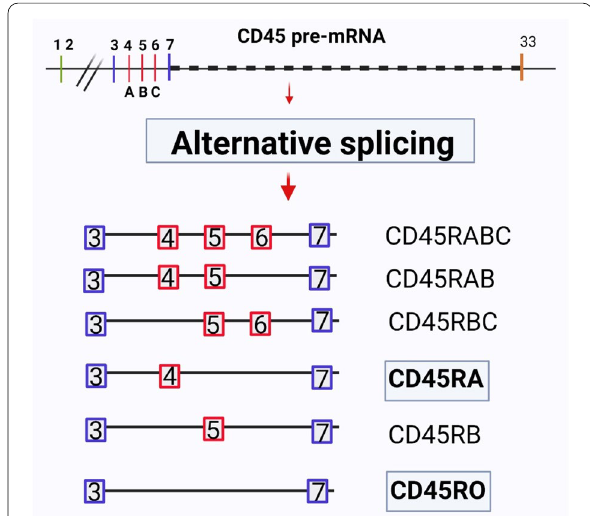
Fig. 1 Splicing of CD45 pre-mRNA results in generation of distinct isoforms. The figure demonstrates alternative splicing of CD45 isoforms in humans as information on cattle has not been published yet. CD45 pre-mRNA has 33 exons in humans, numbered from 1 to 33 in this figure. Differential splicing of exons 4/A, 5/B and 6/C generates